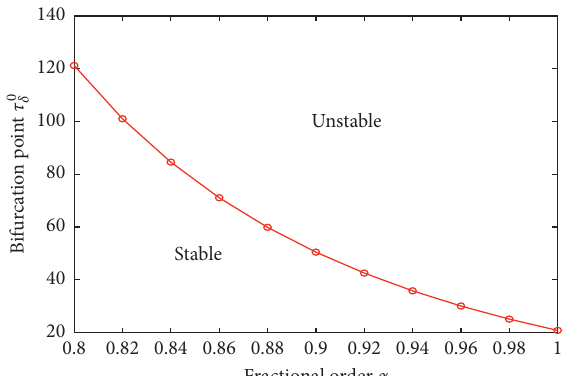
Figure 7: The impact of the fractional order α on the bifurcation value τ 0